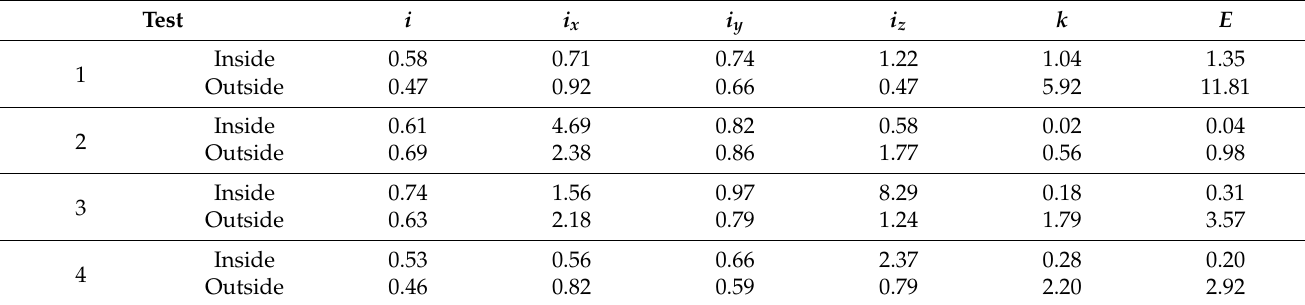
Table 4. Turbulence intensity i (longitudinal component, i x ; transversal component, i y ; vertical